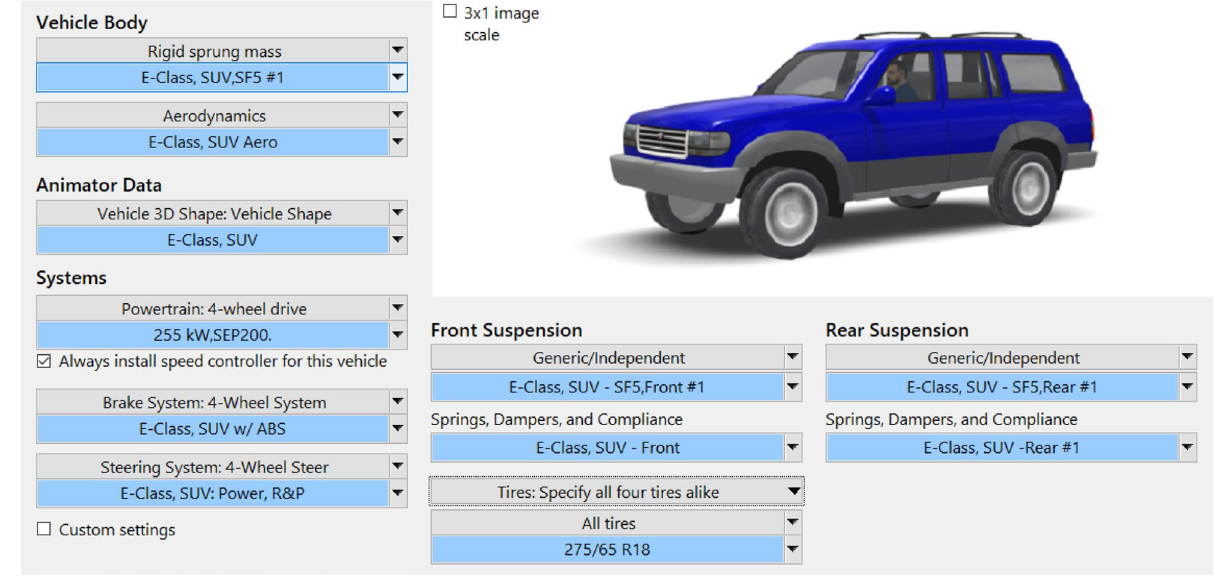
Figure 9. CarSim modeling